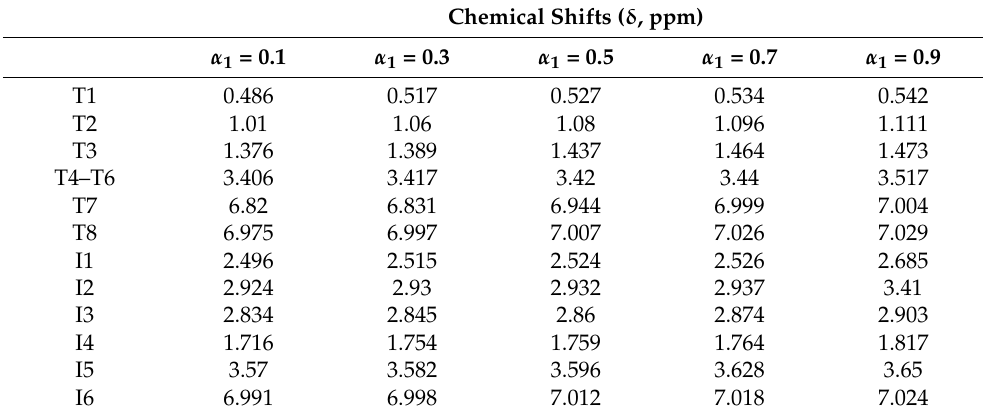
Table 4. 1 H NMR chemical shifts ( δ , ppm) of IMP+TX-100 mixtures in aqueous system. Chemical Shifts ( δ ,